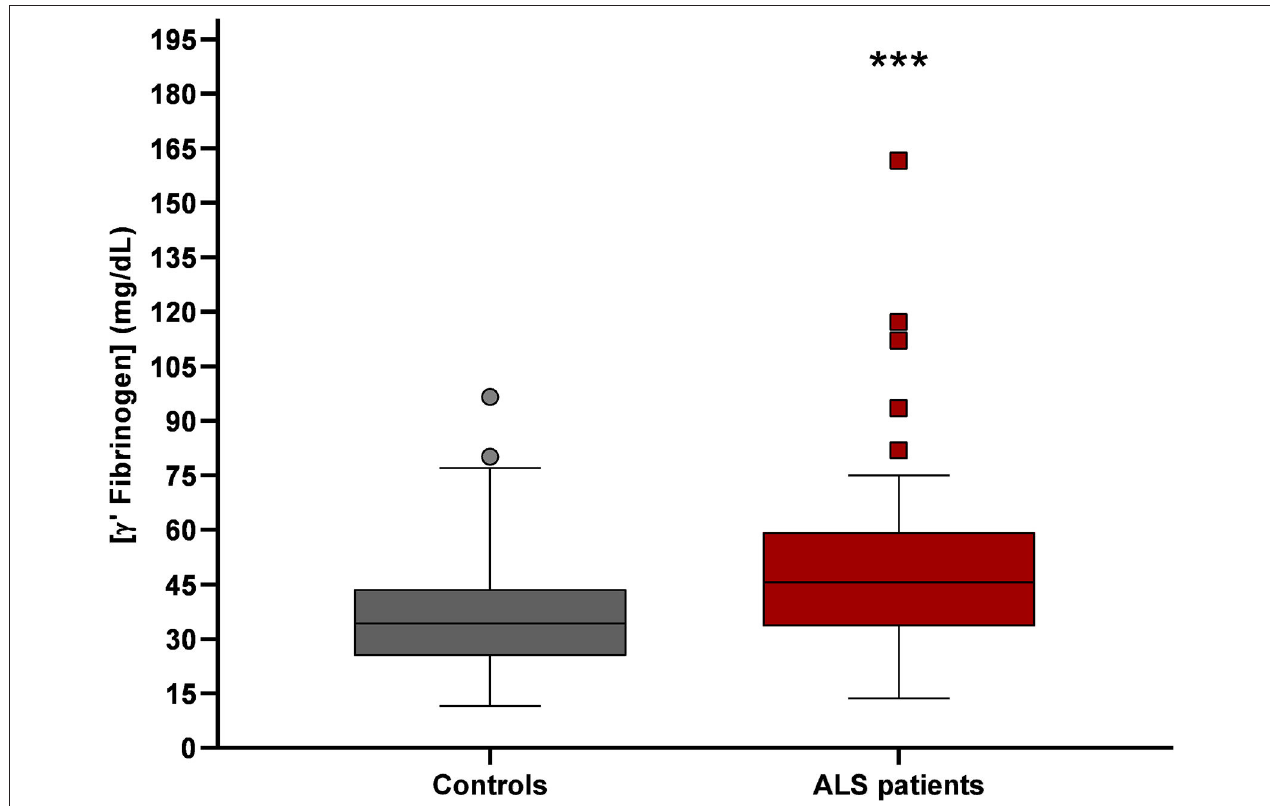
FIGURE 1 | γ ’ fibrinogen levels in plasma from controls ( n = 82) and ALS patients ( n = 67). γ ’ fibrinogen values of ALS patients were significantly higher than in controls (*** p = 0.0006).